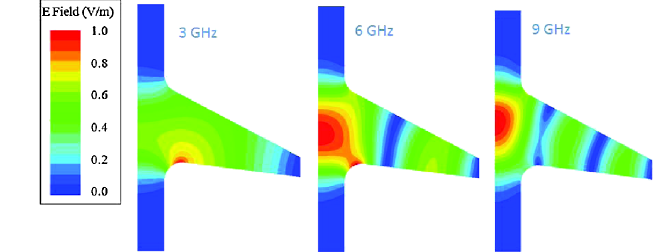
FIG. 7. (Color) Profiles, outline drawing, and field maps for an axisymmetric modified pillbox cavity with harmonically related eigenfrequencies for its first three axisymmetric modes.